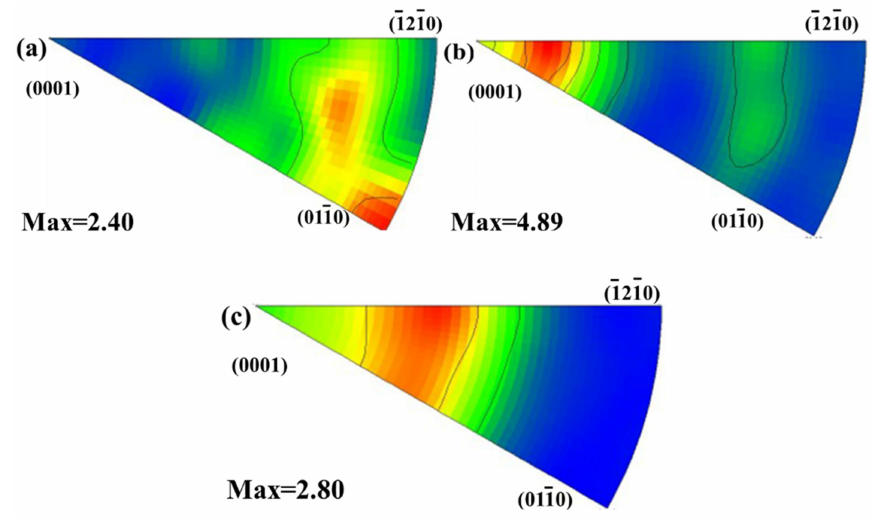
Figure 9. Inverse pole figures of ECAP alloys processed from ( a ) 623 K-4P, ( b ) 623 K-12P and ( c ) 573